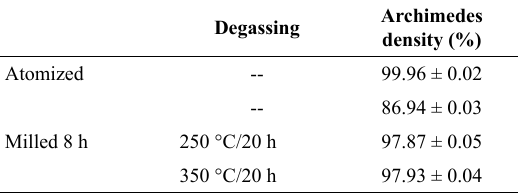
Table 3. Archimedes density of atomized and 8-h milled samples, sintered at 525 °C under 60 MPa.